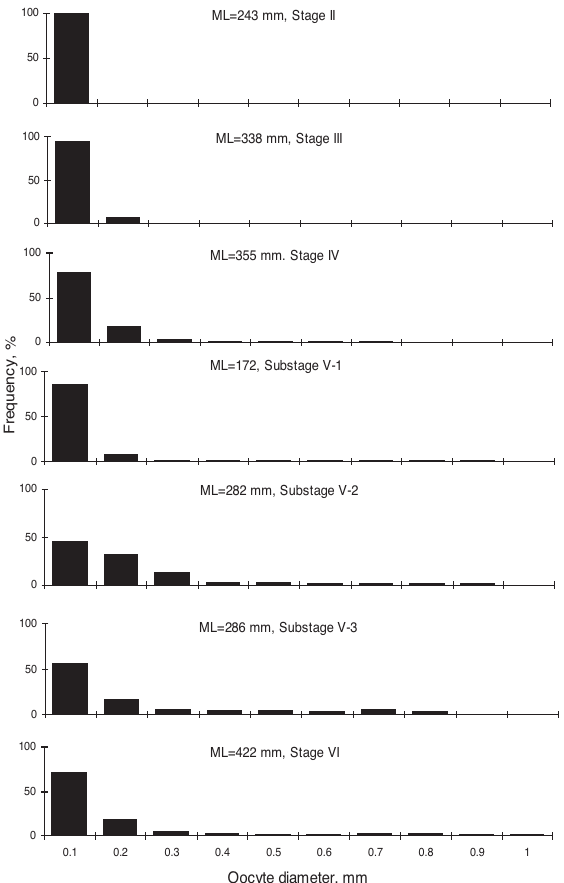
F IG . 4. – Changes in oocyte size distribution in individual maturation